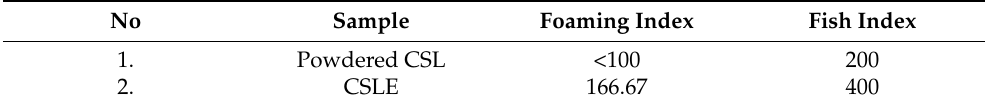
Table 3. Foaming and fish index of Calophyllum soulattri leaves.